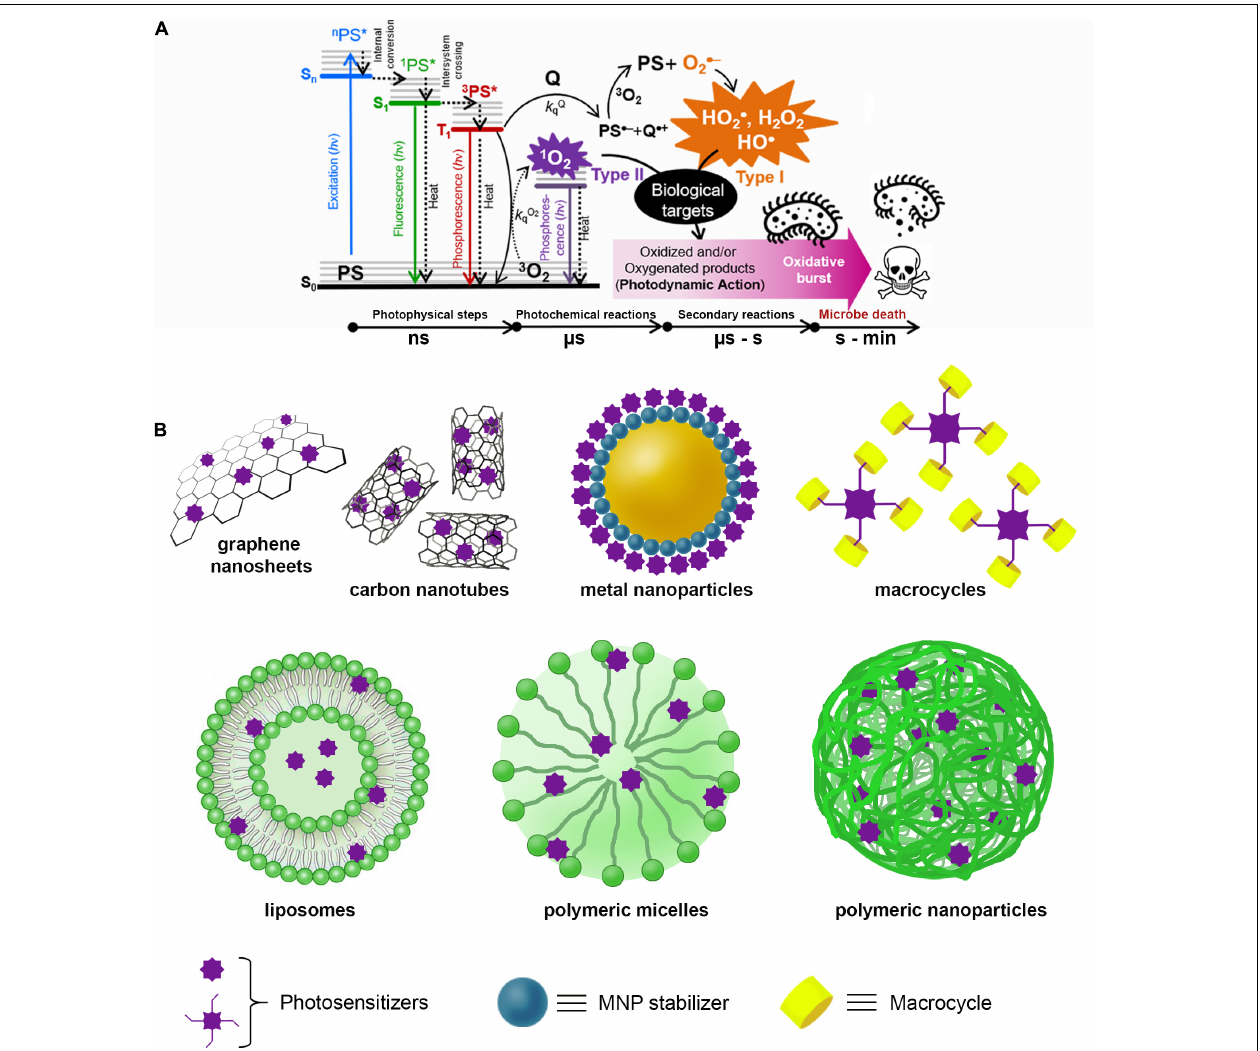
FIGURE 1 | (A) Schematic representation of the antimicrobial photodynamic therapy (aPDT) process that begins with the absorption of a photon ( h ν ) of appropriate wavelength by the ground state (S 0 ) of the PS to populate any excited singlet state of higher energy (S n ). Excess vibronic energy is released rapidly ( < 1 ns) as heat by non-radiative processes to populate the lower singlet excitation state S 1 ( 1 PS*). Subsequently, the 1 PS* state can decay to S 0 on the nanosecond time scale by radiative (fluorescence) and non-radiative (heat processes), in parallel with the population of the excited state lower triplet T 1 ( 3 PS*) by an intersystem crossing process. In aerobic conditions, the reaction of 3 PS* with a quencher molecule (Q) or molecular oxygen ( 3 O 2 ) by charge transfer (Type I) or energy-transfer (Type II) will produce reactive oxygen species (ROS), which in turn react with biological targets (lipids, DNA, proteins) inducing malfunctioning and, eventually, cell death. (B) Representative supramolecular architectures used for aPDT with PS non-covalently conjugated to carbon-based nanomaterials [e.g., carbon nanotubes (CNTs) and graphene sheets]; metal nanoparticles (e.g., gold, silver, copper, or platinum) stabilized with different compounds (e.g., amino acids, proteins, polymers, biopolymers, etc.); macrocycles (e.g., cyclodextrins, calixarenes, cucurbituriles, pillararenes, etc.); and finally, PS entrapped in liposomes, spherical micelles, and polymeric